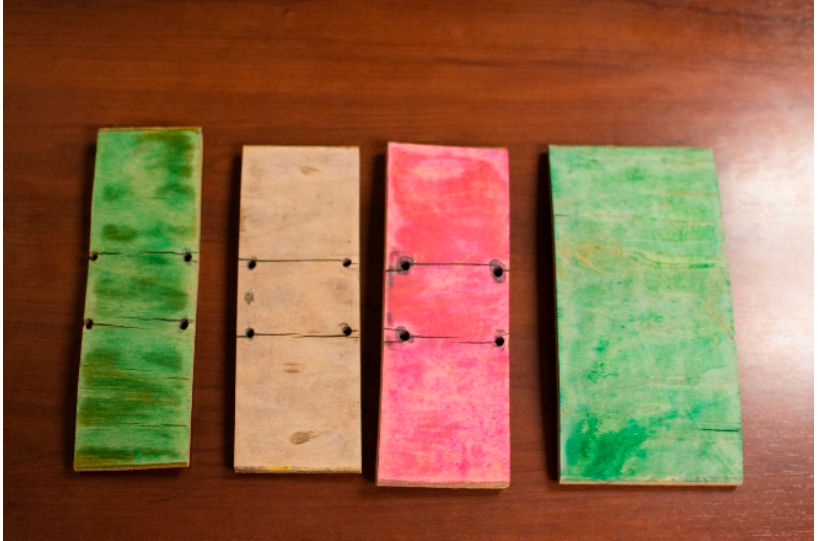
Figure 12. Bottom view of samples after soak/dry moisture durability test (ANSI/HVPA EF 2009 [4]).